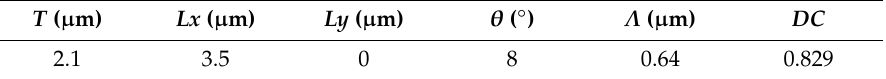
Table 1. Optimized parameters for the grating coupler for TE polarization ( λ = 1.55 µ m).